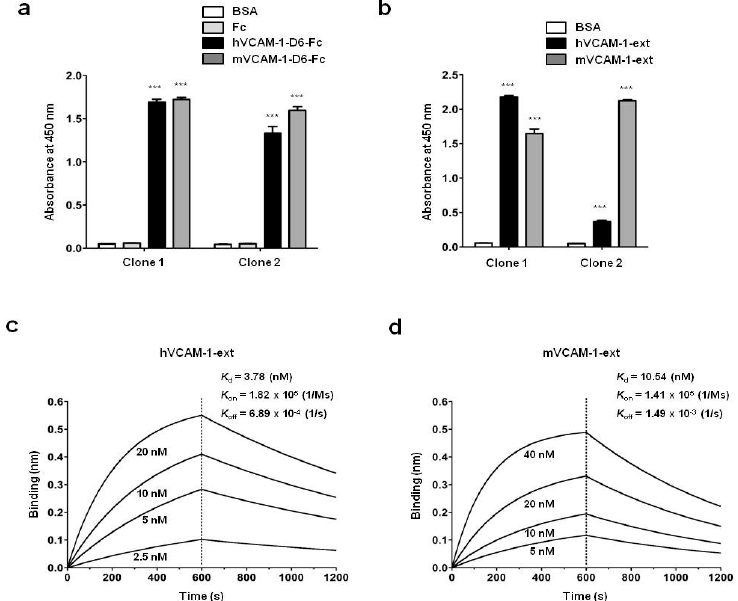
Figure 3. Generation and characterization of VCAM-1-D6 huMabs specific to human and mouse VCAM-1-D6. Bar graphs illustrate the binding specificity of VCAM-1-D6 huMab Clones 1 and 2 to hVCAM-1-D6-Fc, mVCAM-1-D6-Fc, and Fc ( a ), or to hVCAM-1-ext and mVCAM-1-ext ( b ). Following